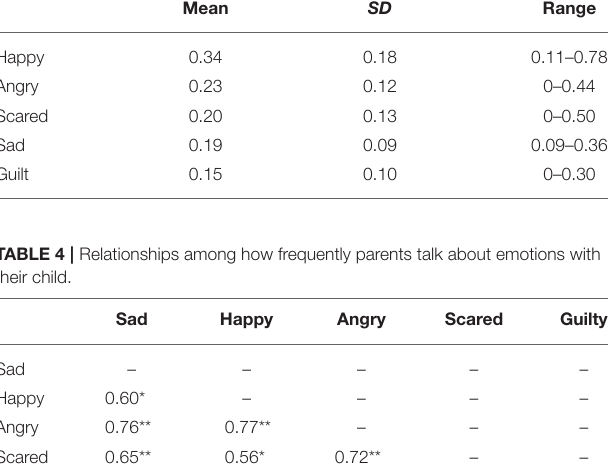
The table presents the average percentage of emotion words across